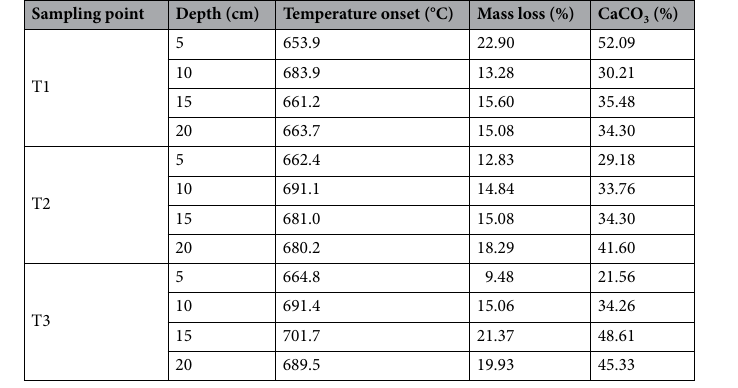
Table 2. Results obtained from TG-DSC analysis. Temperature onset is the temperature when the decomposition of carbonates starts, and Mass loss correspond to the amount of released CO 2 .